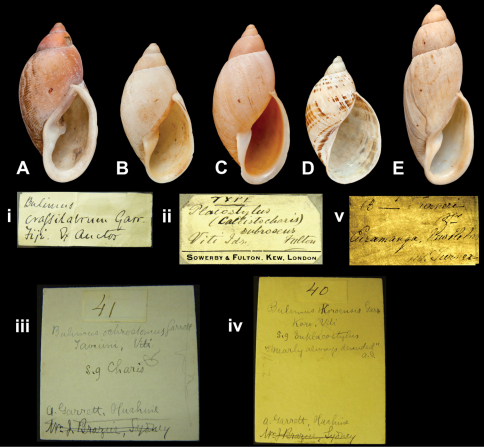
A–C
Callistocharis species A, i
Callistocharis crassilabrum (Garrett, 1872), syntype NHM 20030801 (H = 44.0) B, iii
Callistocharis ochrostoma (Garrett, 1872), probable syntype NHM 20030803 (H = 35.8) C, ii
Callistocharis subroseus (Fulton, 1915), holotype NHM 1919.12.31.50 (H = 43.8) D, v
Poecilocharis turneri (Pfeiffer, 1860), lectotype NHM 1975237 (H = 32.9) E, iv
Euplacostylus koroensis (Garrett, 1872), probable syntype NHM 20030802 (H = 51.2).